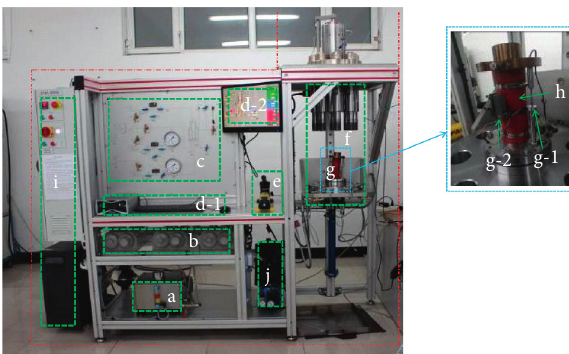
Figure 2: Experimental system of rock mechanics. (a) oil source; (b) axis, enclosure, and pore water loading pump; (c) monitoring and control panels; (d): computer acquisition control system d-1, control system display and d-2, and the host of the control system; (e) base lift pump; (f) Experimental cylinder block; (g) base (g-1: axial sensor; g-2: circumferential sensor); (h) rock sample; (i) power; and (j) pressure pump for confining pressure